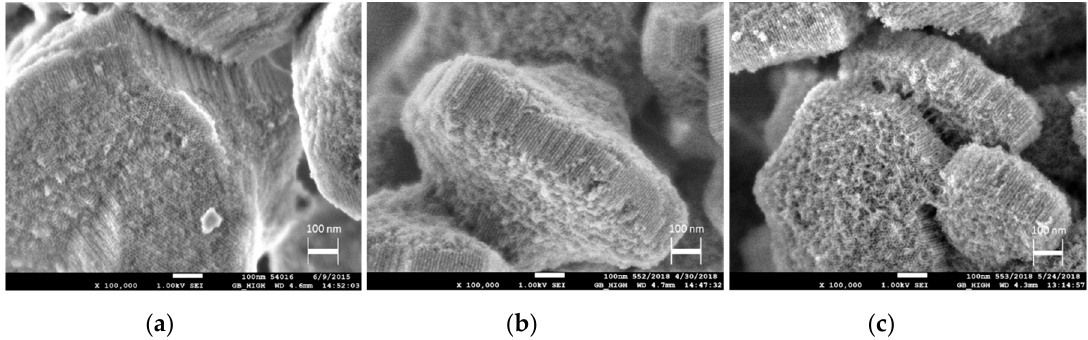
Figure 3. SEM images of SBA ‐ 15 ( a ), Zr ‐ SBA ‐ 15 I ( b ) and Zr ‐ SBA ‐ 15 II ( c ) catalysts (all images × 100,000).